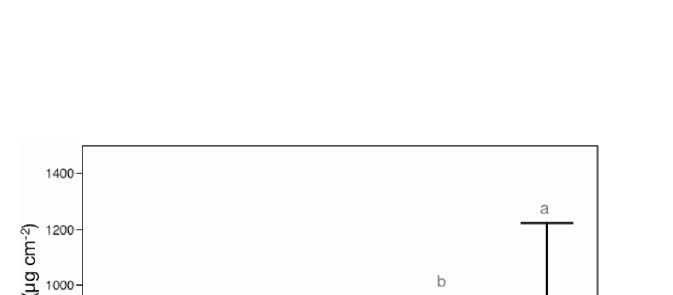
Figure 1. Elemental maps of Col-0, OsZIP7-OE and the glabrous-1 mutant leaves. Maps show Zn localization (in red) in leaves of plants grown under 50 nM Zn ( A ), 50 μM Zn ( C ) and 100 μM Zn ( E ), and Zn and Ca (in green) overlay in leaves from plants grown under 50 nM Zn ( B ), 50 μM Zn ( D ) and 100 μM Zn ( F ).